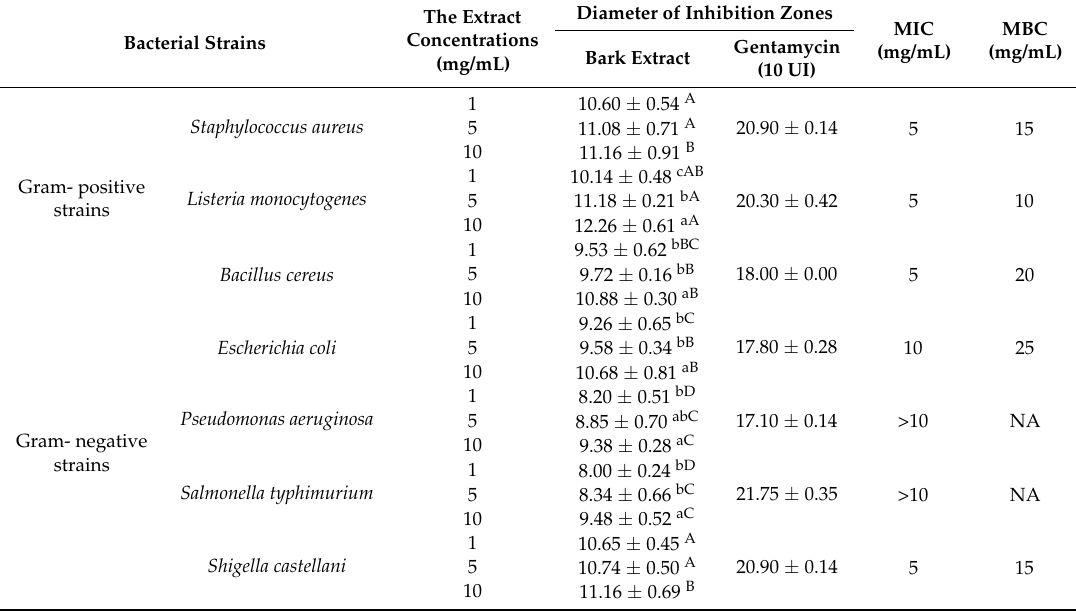
Table 4. Antibacterial activity of T. ramosissima bark extracts at different concentrations. Minimum bactericidal concentration (MBC), minimum inhibitory concentration